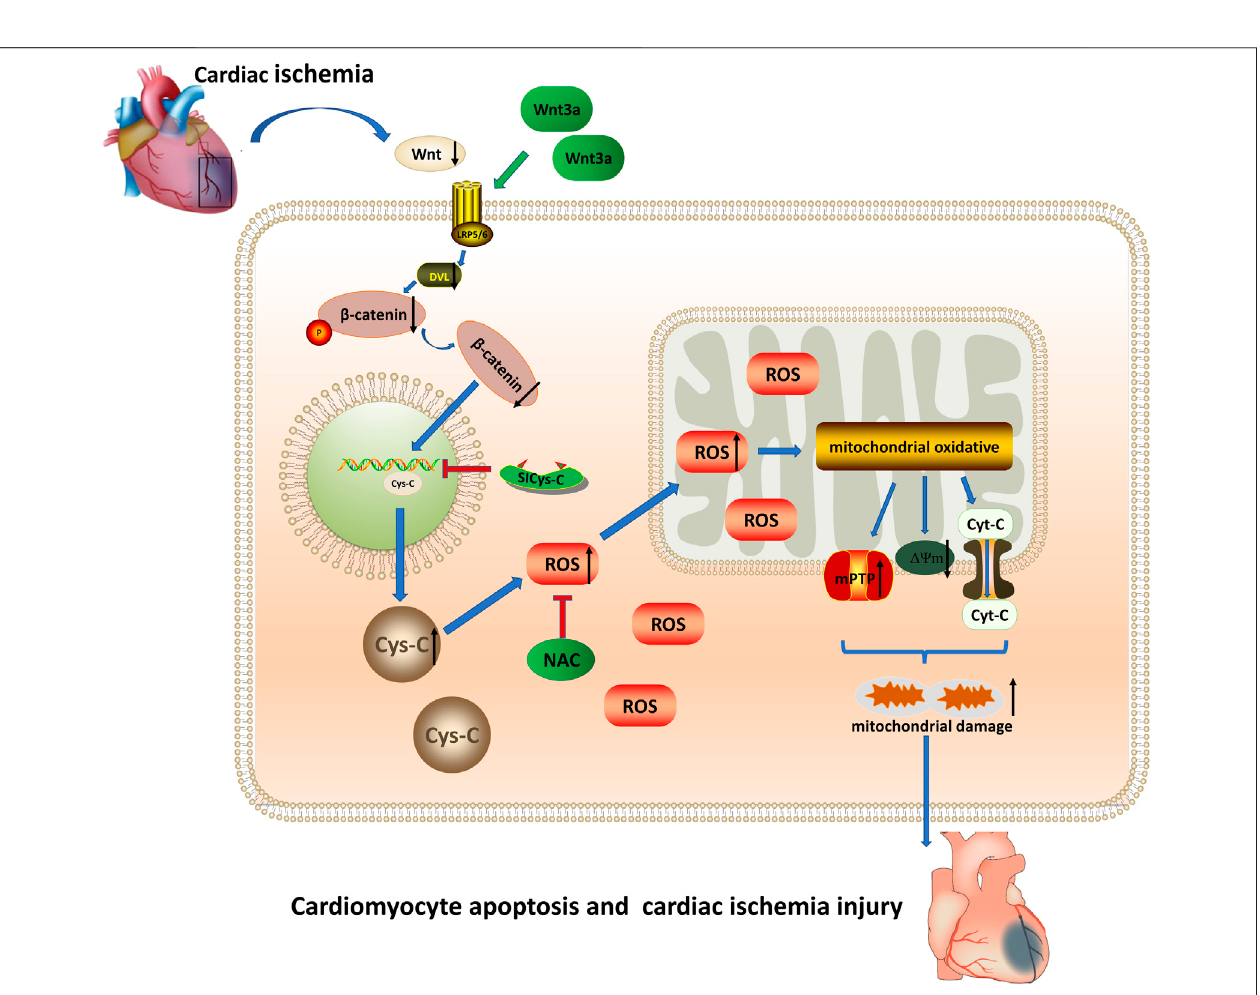
FIGURE 4 | Wnt 3a/ β -catenin reduce the expression of cytoplasmic Cys-C through transnuclear action, and reduce the occurrence of mitochondrial oxidative stress injury induced via Cys-C/ROS, inhibited Cys-C/ROS-induced cardiomyocyte apoptosis and cardiac injury. Cys-C, Cystatin C; ROS, reactive oxygen species; mPTP, mitochondrial permeability transition pore; Cyt-C, mitochondrial apoptotic protein; ΔΨ m, mitochondrial membrane potential; LRP5/6 Frizzled – LRP5/6 receptor; Dvl, dishevelled protein; NAC, cytosolic ROS scavenger; Si-CysC, siRNA technology to knock down the expression of Cys-C.